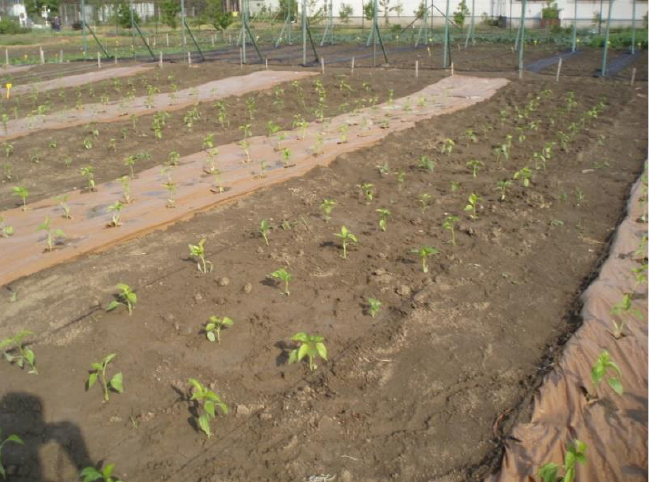
Figure 1. The cultivation area with and without mulch film. There was a high supply of phosphorus and potassium in the soil (Table 3). For this reason, autumn stock fertilization with phosphorus and potassium was not